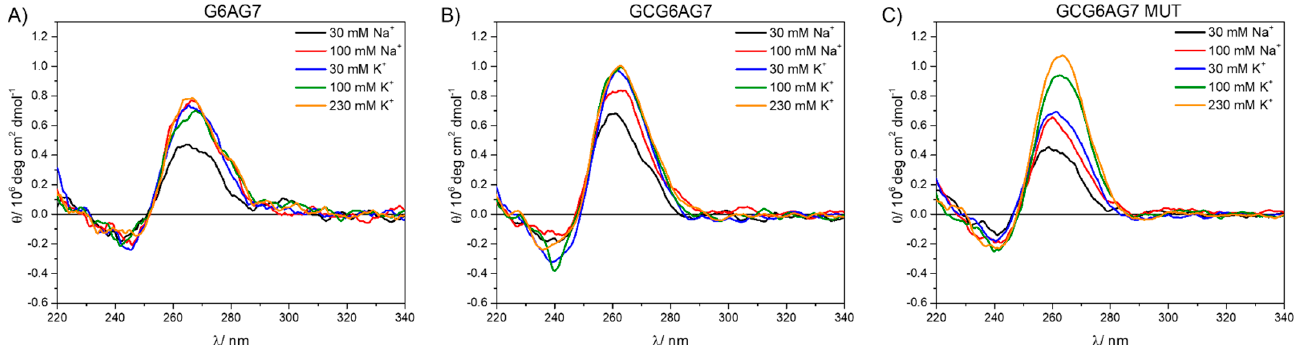
Figure 2. Circular dichroism spectra for DNA sequences G6AG7 ( A ), GCG6AG7 ( B ), and GCG6AG7 MUT ( C ) in a phosphate-buffered solution with cations Na + and K + in the concentration range from 30 mM to 230 mM.